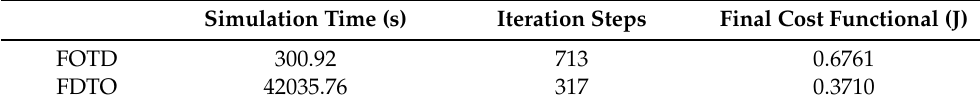
Figure 4. Comparison of convergence process by FOTD and FDTO approaches. Table 1. Comparison of simulation performance between FOTD and FDTO